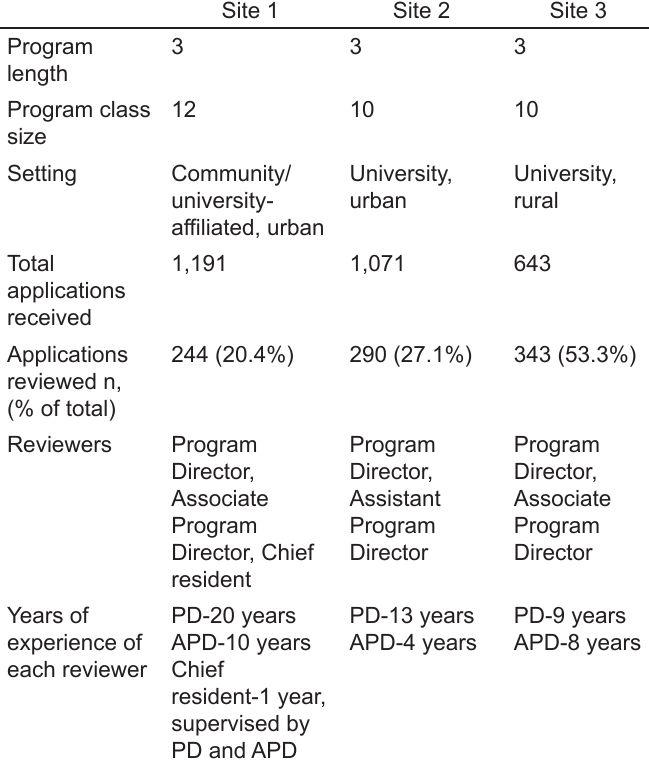
Table 1. Demographic characteristics of the three participating program sites and application reviewers at the respective